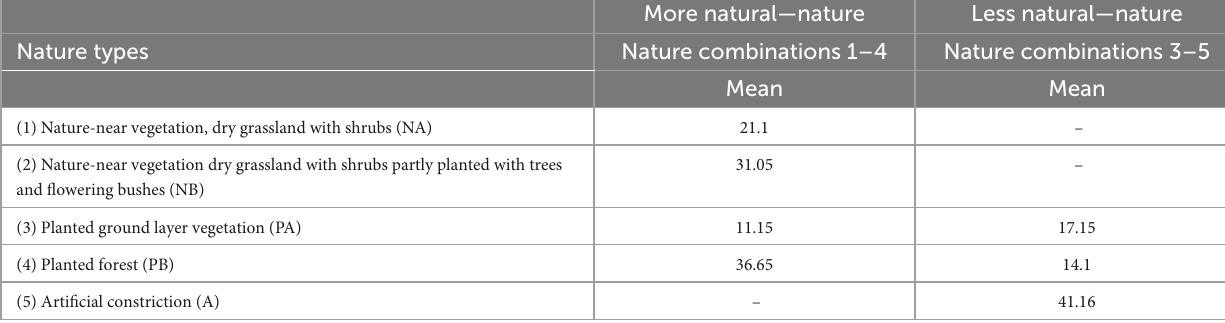
TABLE 7 Mean of visitor preferences of nature types in